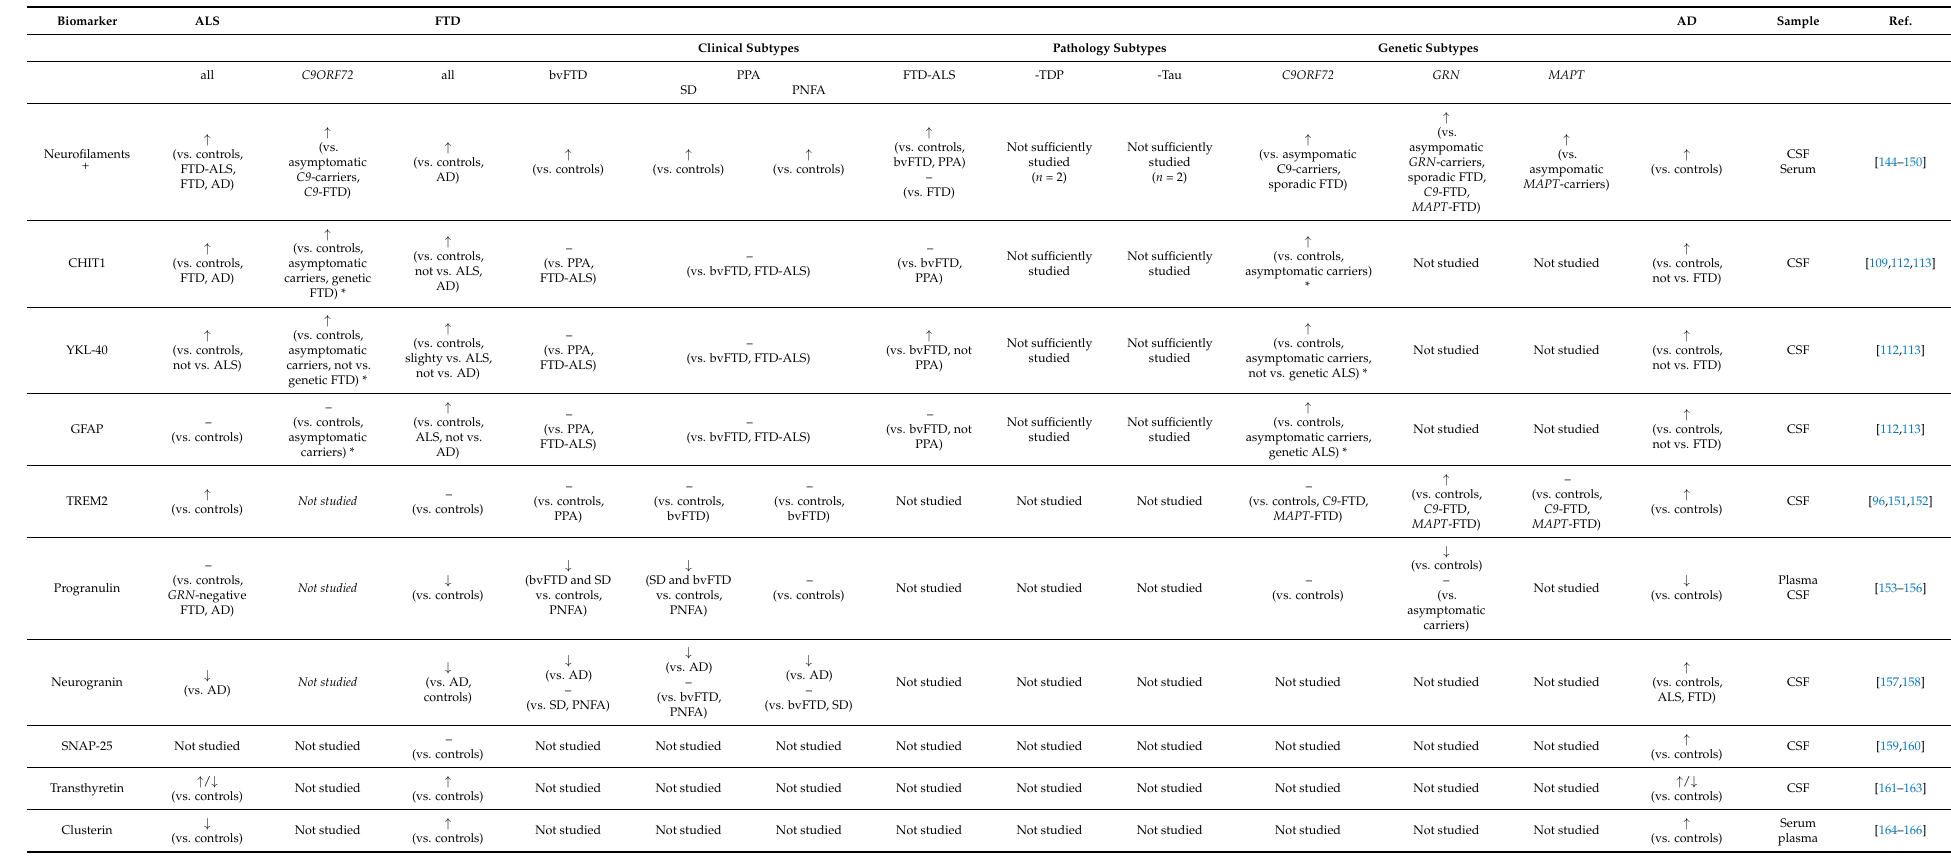
Table 1. Hypothesis driven investigation of biomarkers in ALS-FTD spectrum diseases.